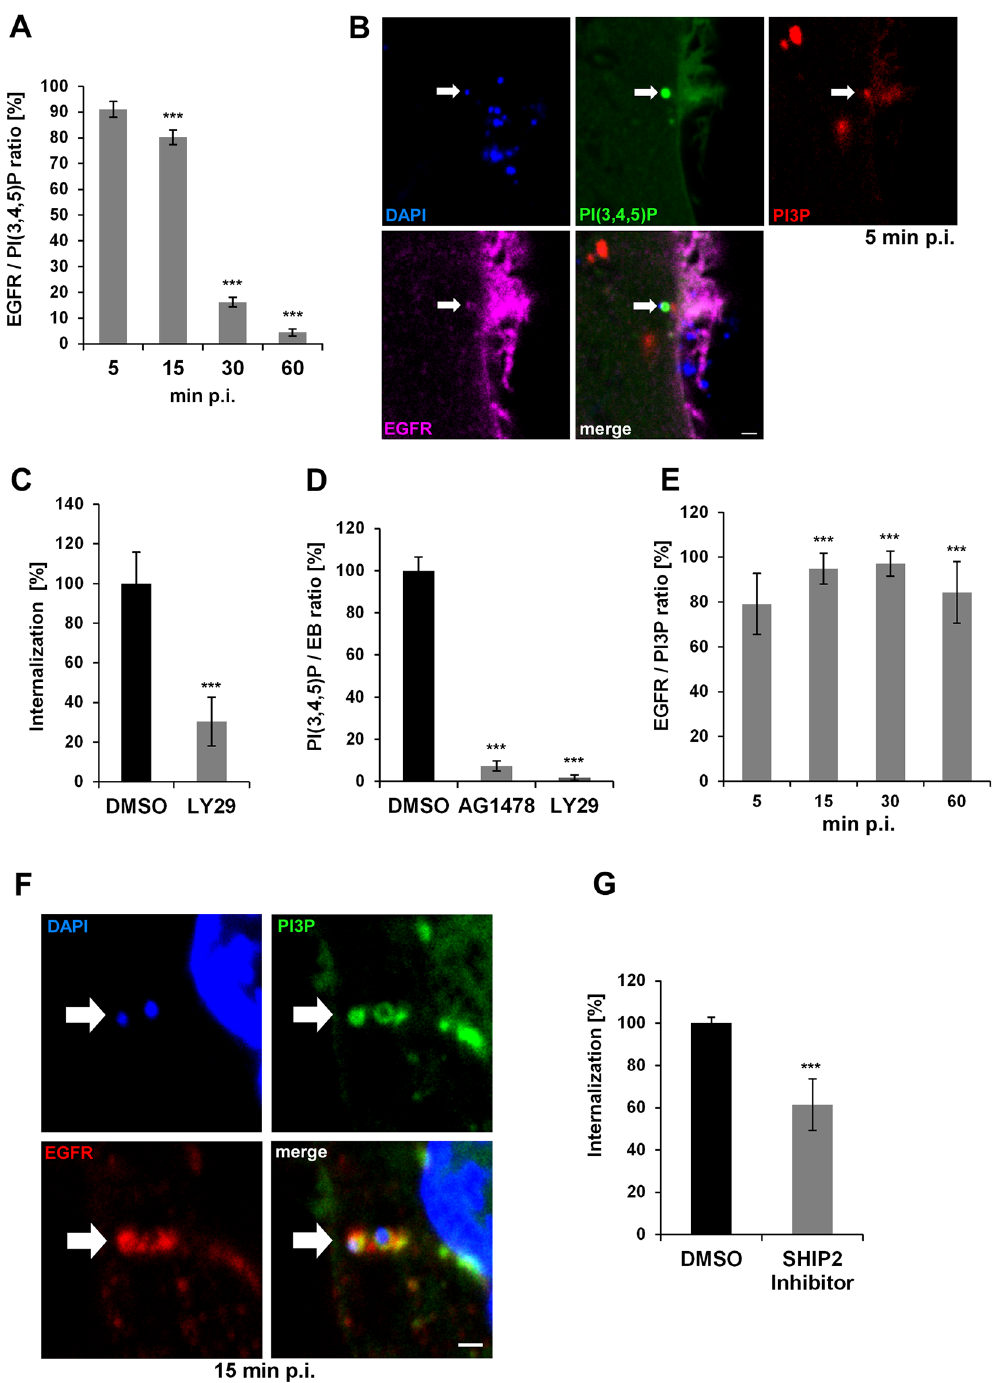
Fig 1. Entry of C . pneumoniae EBs is PI3K dependent. (A) Quantificationof colocalization of PI(3,4,5)P and EGFR in cells transiently transfected with Btk-PH-GFP. Cells were infected at MOI 5, fixed with PFA at the indicated time points (5–60 min), and stained for endogenous EGFR using anti-EGFR, anti-rabbitAlexa594 and DAPI. Confocalimages of 30 individual cells were used to analyzecolocalization (n = 3). (B) The arrow marks a bacterial entry site at 5 min p.i. visualizedby confocalimaging. The bacterialDNA stainedwith DAPI colocalizeswith the “ring-like”signal of PI(3,4,5)P detected with Btk-PH-GFP. Furthermore, the entry site is marked by PI3P detected with mCherry-2xFYVE and the endogenous EGFR surroundingthe internalizedEB. (C) Quantificationof C . pneumoniae internalizationin cells pretreatedwith LY29 (50 μ mol) for 2 h prior to infection. At 2 hpi internalization